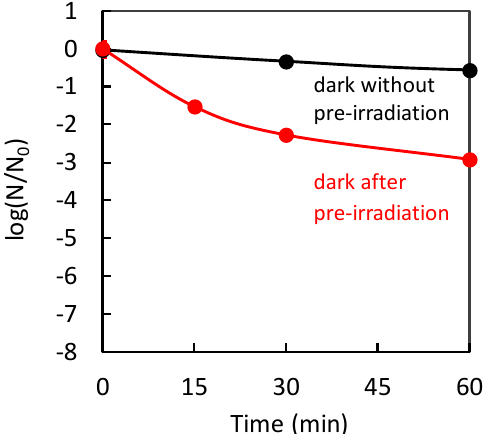
Figure 9. Inactivation of bacteriophage Q β by Cu(II) / TiO 2 under dark conditions without pre-irradiation (black) and after pre-irradiation treatment (red) [32]. The pre-irradiation treatment was conducted using a white fluorescence lightbulb passed through a UV cut-off film below 400 nm.